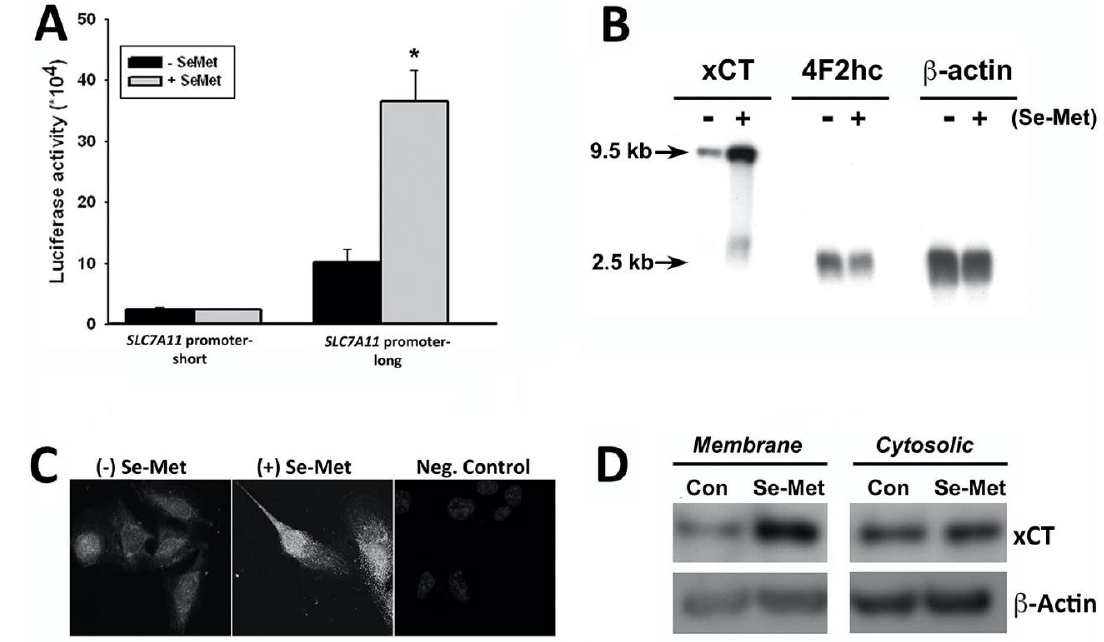
Figure 2. Se-Met-induced expression of xCT (SLC7A11): ( A ) luciferase reporter assay of Se-Met (1 mM)-induced SLC7A11 (xCT) promoter activation in in ARPE-19 cells transfected with luciferase reporter constructs containing either the short or long form of SLC7A11 promoter (* p < 0.001 compared to the control (−Se-Met) SLC7A11 promoter-long cells); ( B ) northern blot analysis of xCT and 4F2hc expression in control and Se-Met-treated ARPE-19 cells; ( C ) immunocytochemical analysis of xCT protein in ARPE-19 cells cultured in the presence (+Se-Met) or absence (−Se-Met) of selenomethionine (1 mM, 16 h), where cells in which PBS was substituted for primary antibody served as the negative control (Neg. Con); and ( D ) western blot analysis of xCT protein in plasma membrane versus cytosolic protein fractions isolated from ARPE-19 cells cultured in the presence or absence of Se-Met (1 mM, 16 h).